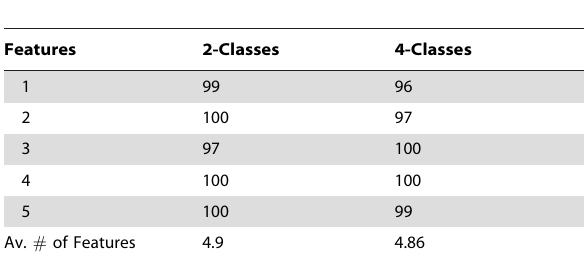
Table 1. Frequencies of Correctly Identified features with Different numbers of